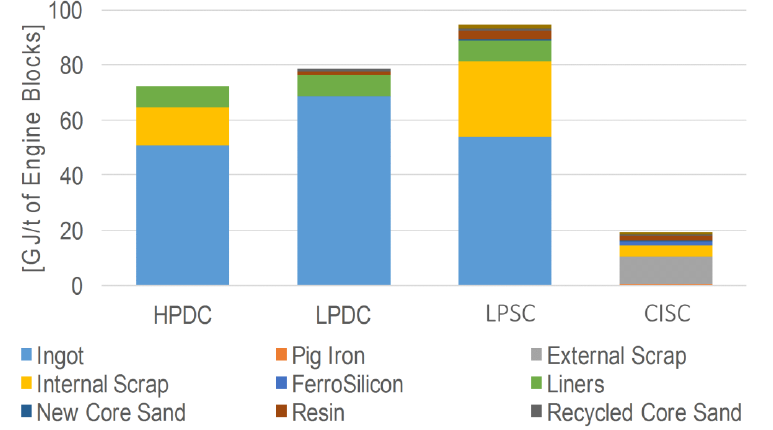
Figure 22. Embodied material energy per ton of engine blocks.